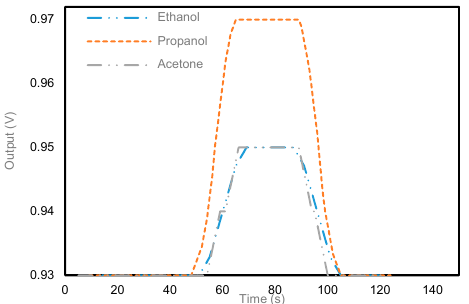
Figure 4. Concentration response for ethanol, propanol,